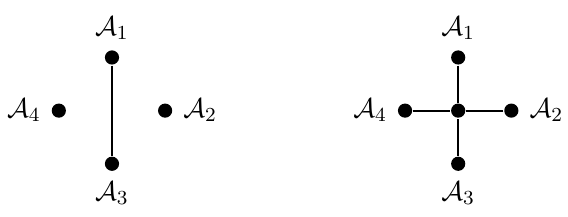
Figure 1 . These discrete graphs capture the entanglement structure of a PT 2 (the BP ^ g f 13 g ) on the left, and a PT 4 (^ g f 1234 g ) on the right. The boundary vertices denote the individual parties, and each edge represents a single unit of entanglement. The holographic entanglement entropy associated to a set of boundary vertices is the minimum cut associated to those